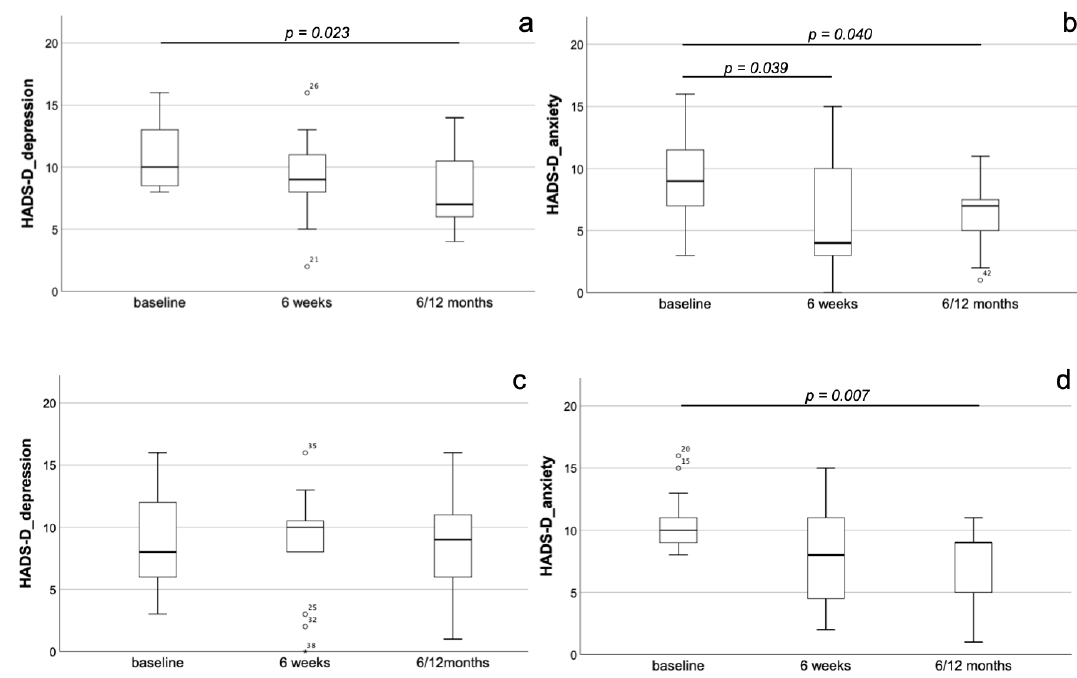
Figure 4. Dynamics of depression and anxiety after TAVI in staging group B. Development of depression ( a , c ) and anxiety ( b , d ) in the depressive ( a , b ) and the anxious ( c , d ) subgroups of staging group B. In the depressive subgroup, a relevant reduction in HADS-D depression values could not yet be detected at the 6-week follow-up but was present at the timepoint of long-term follow-up 6/12 months after TAVI compared to baseline ( a ). With respect to anxiety, there was an early and persisting decrease at the 6-week as well as the ‘long-term 6/12 months’ follow-up compared to baseline ( b ). In the anxious subgroup, there were no changes with respect to both depression and anxiety 6 weeks after TAVI. At the ‘long-term 6/12 months’ follow-up’, a significant reduction of anxiety but not depression could be observed compared to baseline ( c , d